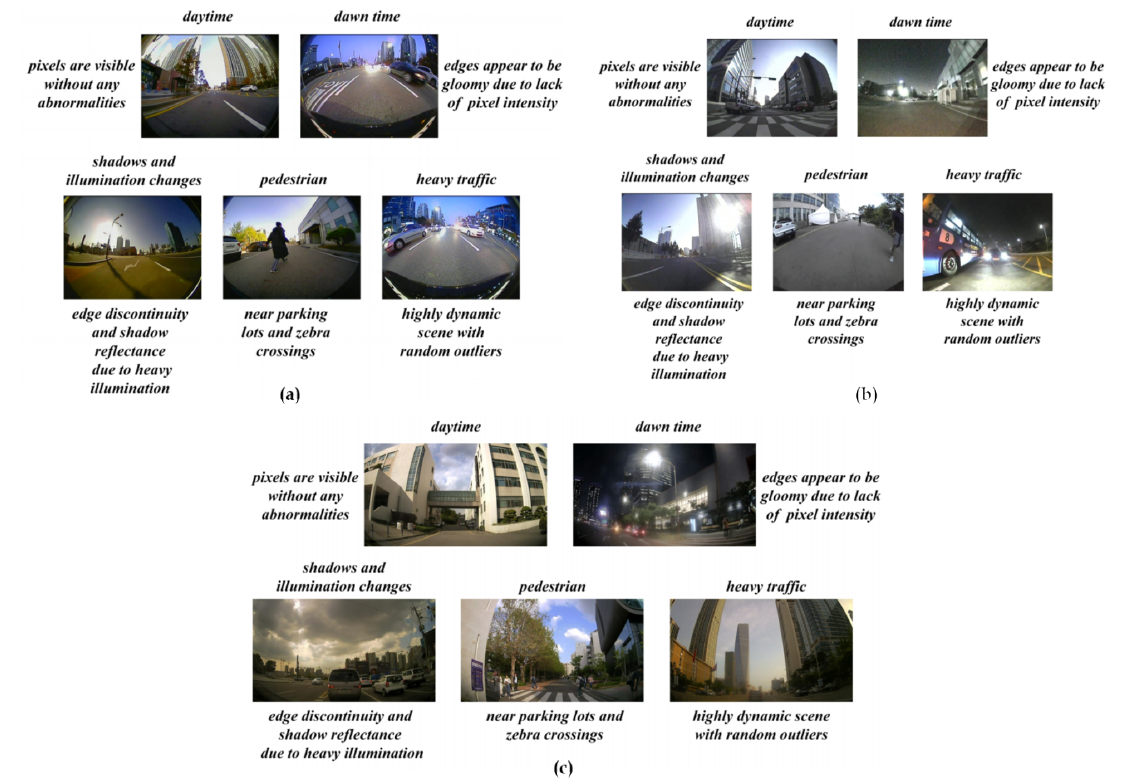
Figure 2. Real-time challenging scenarios: ( a ) fish-eye model (165 ◦ < FOV < 190 ◦ ); ( b ) wide-angle (120 ◦ < FOV < 150 ◦ ); ( c ) super wide-angle (160 ◦ < FOV < 180 ◦